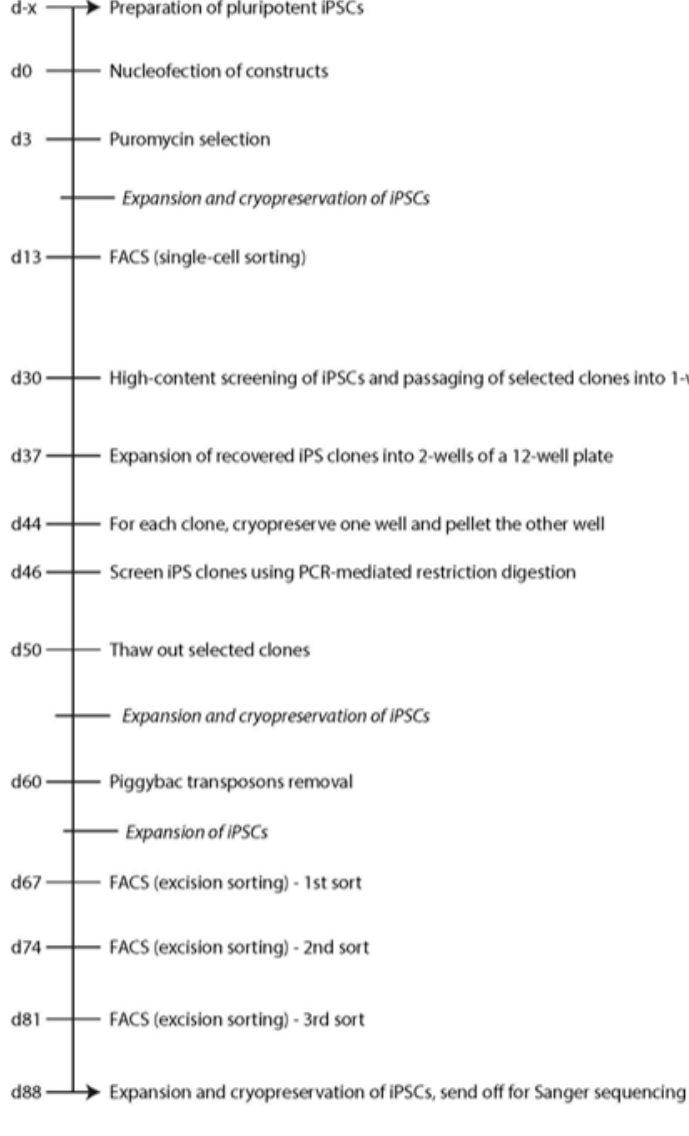
Figure 2. Timeline for the generation of single-cell gene-corrected isogenic iPS cell lines.